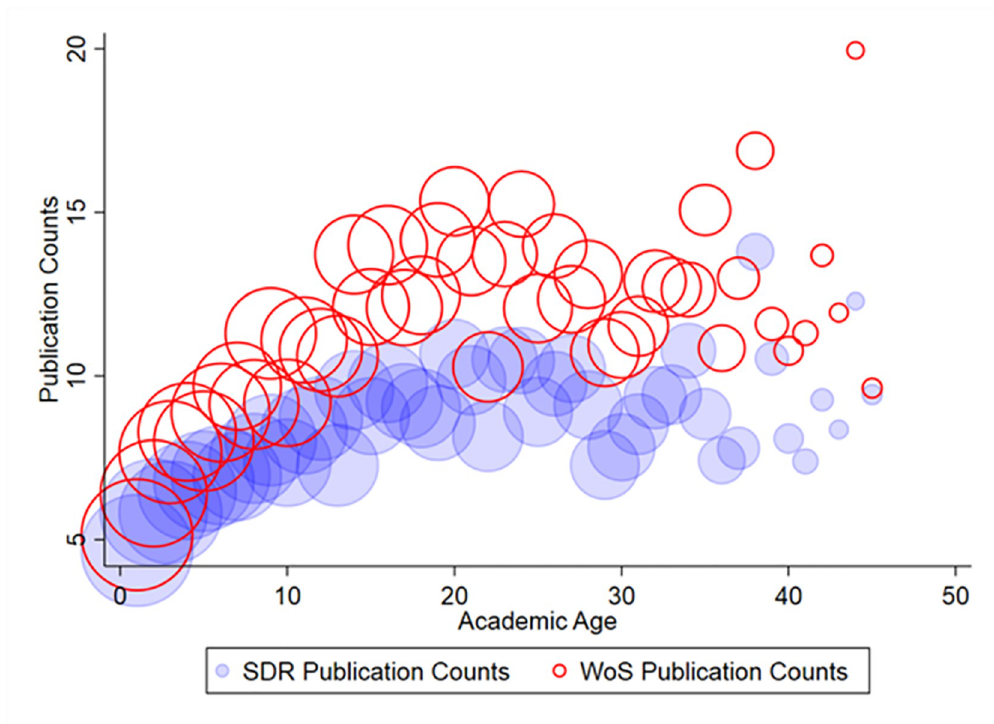
Fig 1. SDR and WoS publication counts by academic age. Notes: This figure shows the average publication counts by academic age from the two sources: the SDR and WoS from 1998–2003. The size of each bubble represents the size of the academic age group. Survey weights were used in creating this